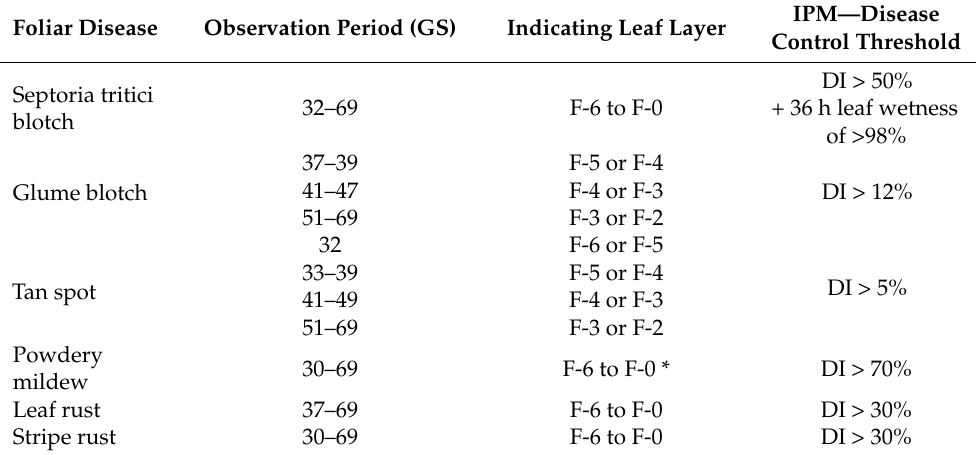
Table 2. Biological–epidemiological disease control thresholds, observation periods and the indicating leaf layer of the IPM wheat model for the major fungal foliar wheat diseases. DI = Disease incidence. Foliar